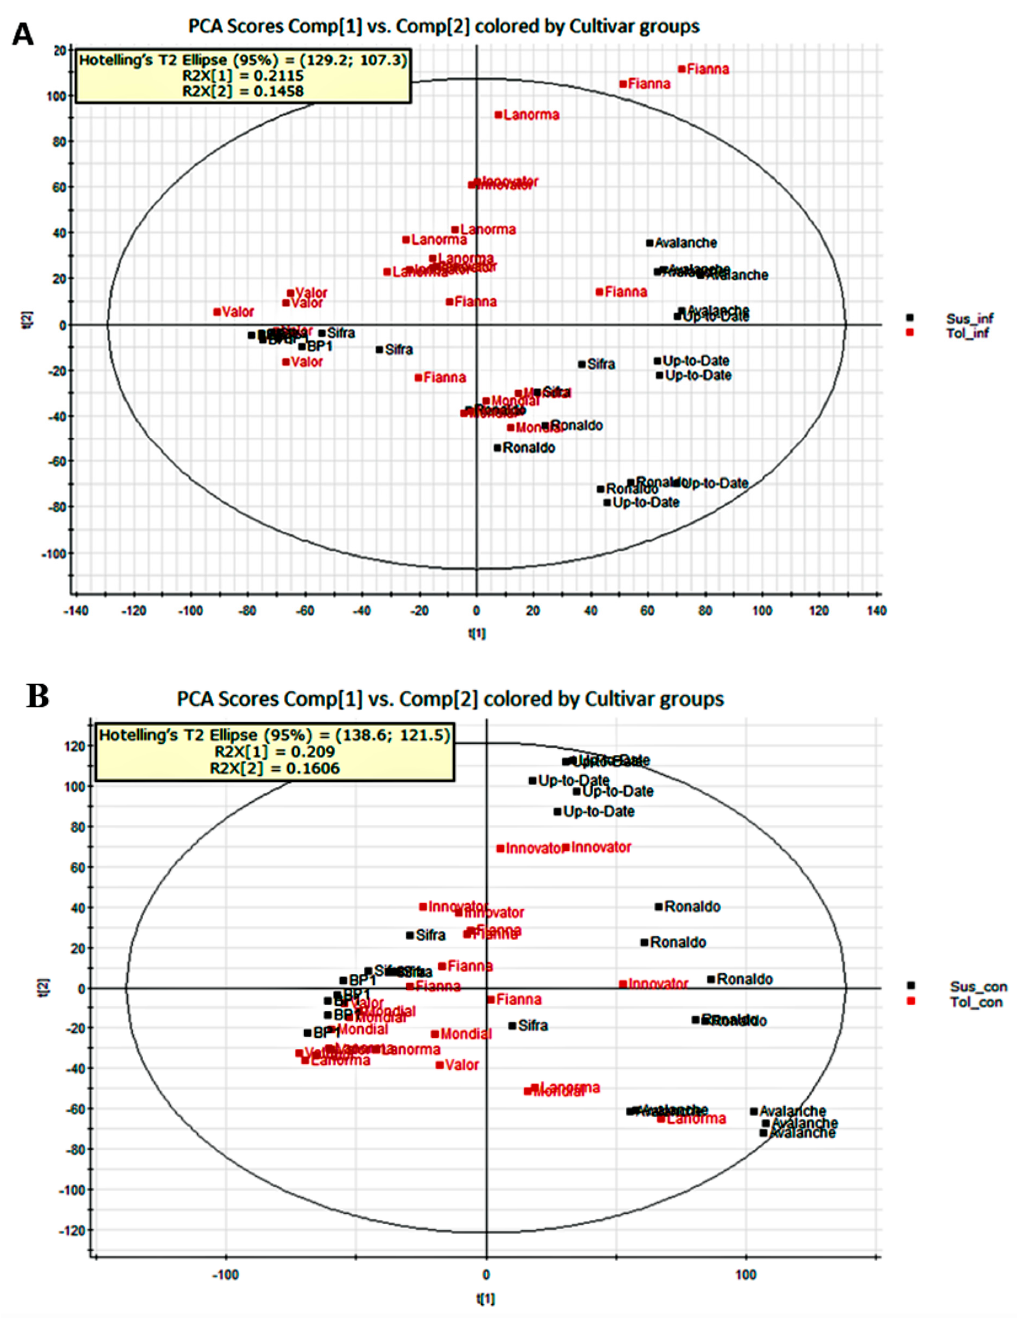
Figure 2. Principal component analysis plot of the ultra-performance liquid chromatography mass spectrometry data illustrating the clustering of the two cultivar groups, ( A ) five tolerant inoculated cultivars (red) vs. five susceptible inoculated cultivars (black), ( B) five tolerant uninoculated cultivars (red) vs. five susceptible uninoculated cultivars (black). Dots represent five replications of each cultivar. Orthogonal partial least squares discriminant analysis (OPLS-DA) was subsequently performed to refine the separation of the two cultivar groups (tolerant and susceptible) obtained by PCA and showed clear di ff erences in the metabolites produced between five susceptible and five tolerant cultivars. In Figure 3, the OPLS-DA scores plots show distinct sample clustering and clear cultivar